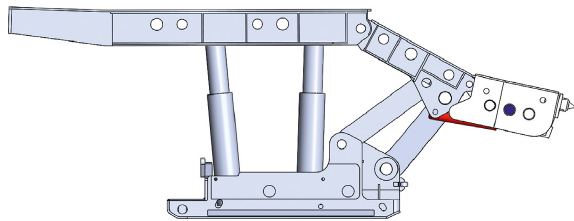
Figure 3: Hydraulic support in longwall top coal